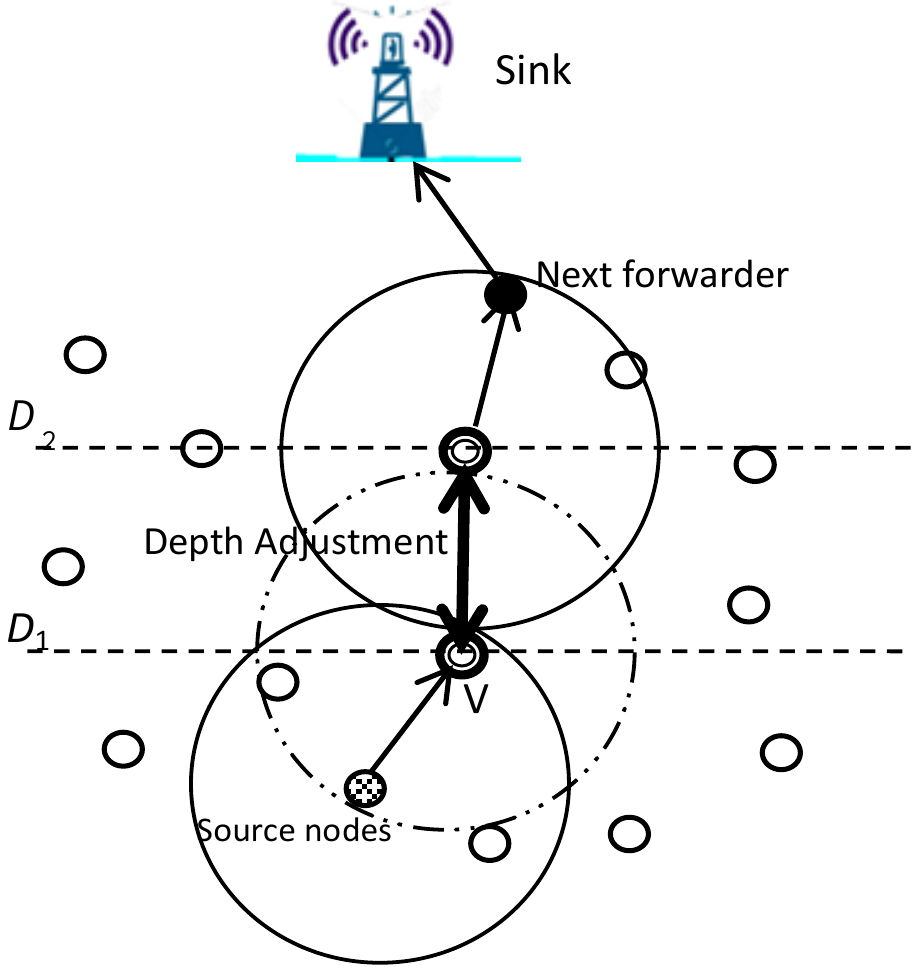
Figure 7. Depth Figure 7. Depth Adjustment.